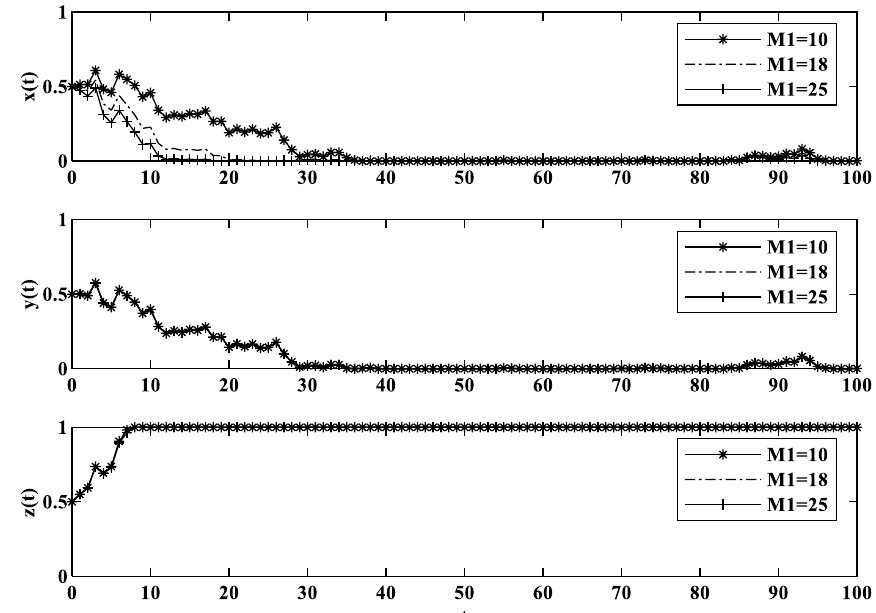
Fig. 4 Impact of illegal penalties ( M 1 ) on evolutionary process under scenario